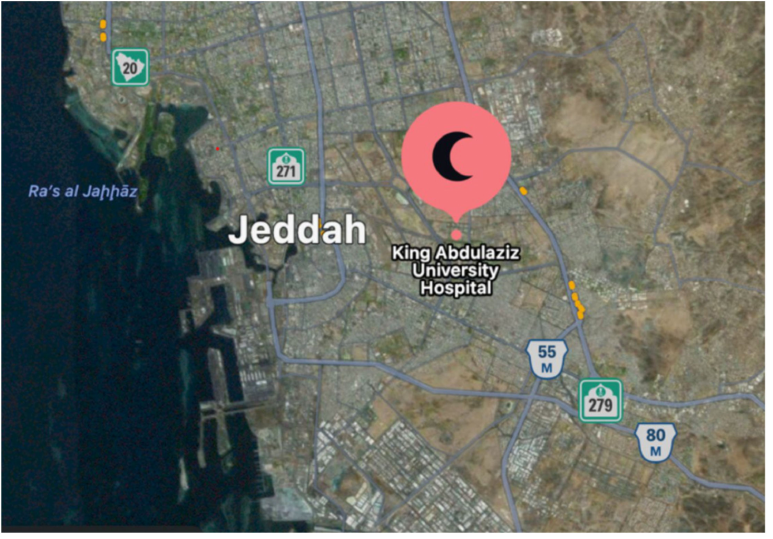
Figure 2. Location of the KAU